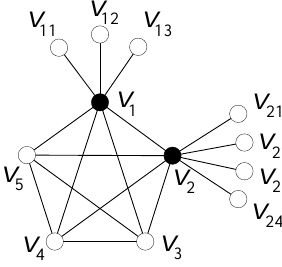
Figure 4. A instance of K 2